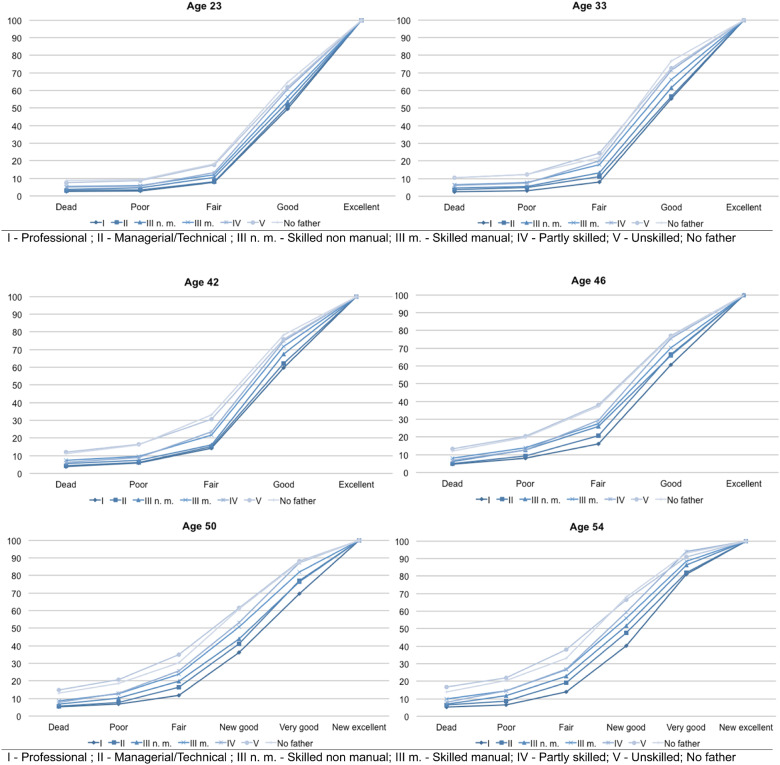
Cumulative distribution functions of self-assessed health according to fathers’ professional status (with mortality) at each age [source: National Child Development Study—NCDS (1958)]. The six graphs represent the cumulated distribution functions of the health status items of the seven possible father's professional status at each age. At age 23 years, the proportion of individuals who have died is <10% regardless of the father's professional status. However it is graphically noticeable that the proportions of premature death at age 23 years among sons of ‘partly skilled’ (IV) or ‘unskilled’ (V) manual workers and individuals without a father at birth are slightly higher than amongst descendants of other father's professional status. Similarly the probability to report a health status as ‘fair’ at age 23 years equals 17.8% for individuals without a father at birth whereas it equals 7.7% for sons of ‘professionals’ (I). In other words, cumulative distribution functions represent the distribution of the misfortune of health according to father’s professional status